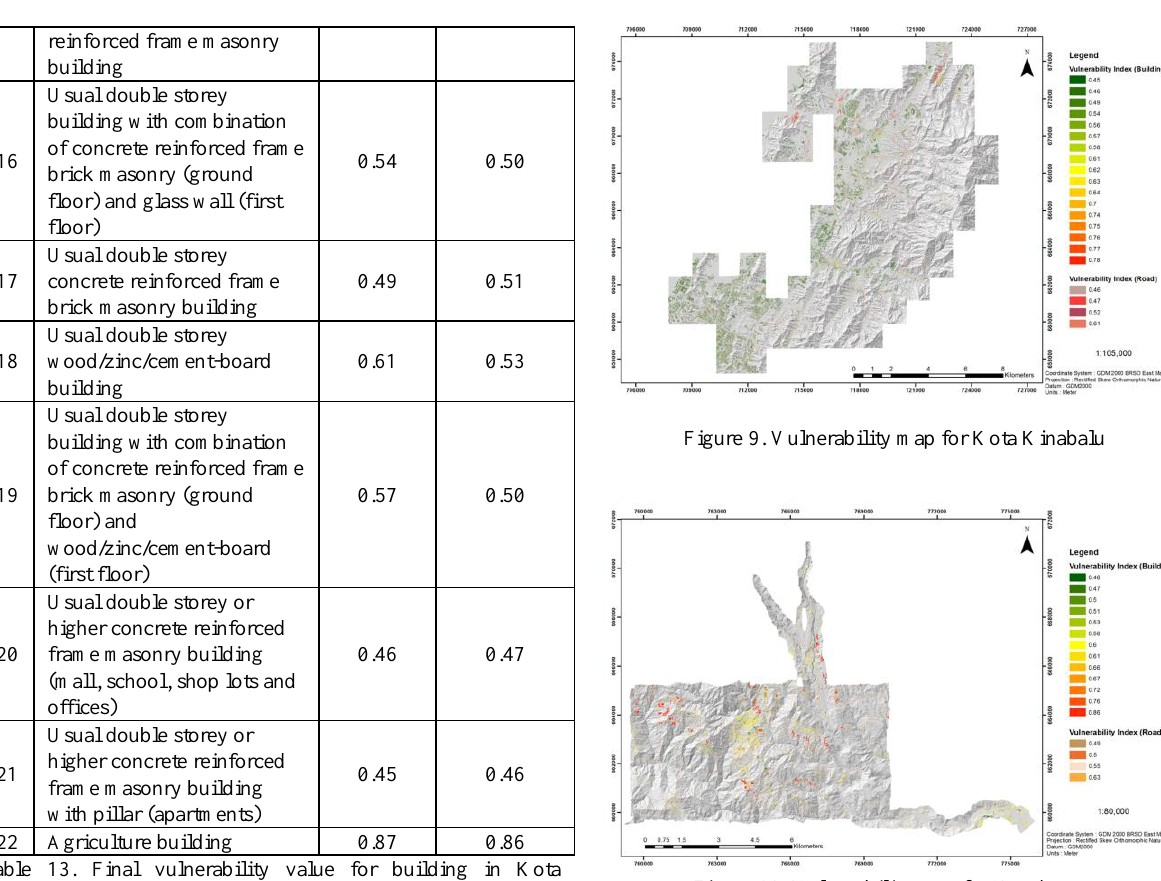
Table 13. Final vulnerability value for building in Kota Kinabalu and Kundasang